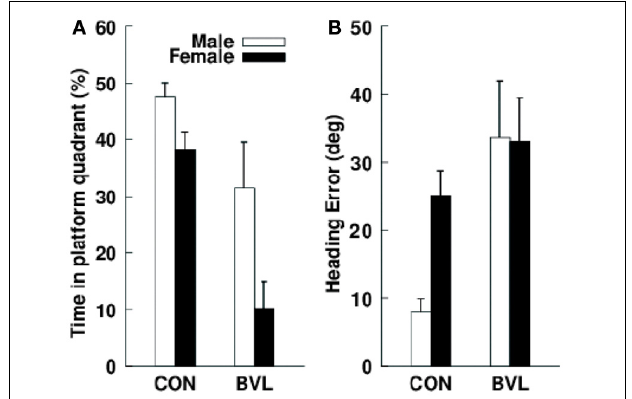
FIGURE 10 | (A) Mean percentage search time that male and female control and bilateral vestibular lesion (BVL) patients spent in the correct platform quadrant during the no-platform trial in a virtual Morris water maze task. (B) Initial heading error in the same task. Data are expressed as means ± s.e.m. Reproduced with permission from Brandt et al.